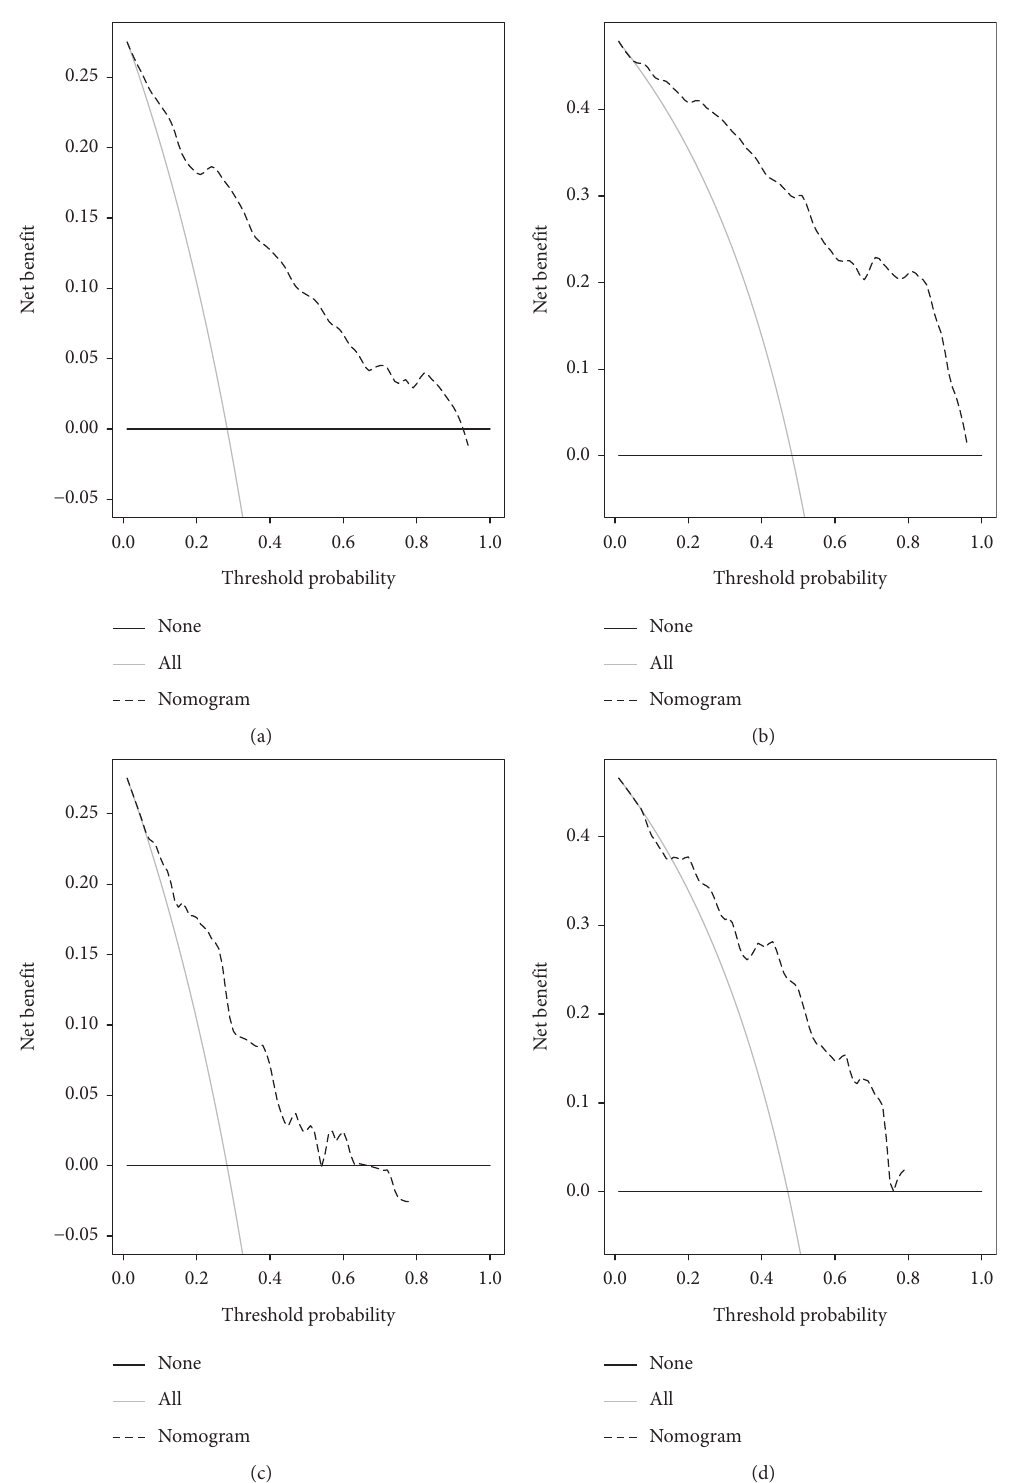
Figure 6: Decision curve analysis of nomogram for predicting 1-year and 3-year cancer-specific survival (CSS) in the training cohort (a, b) and validation cohort (c,